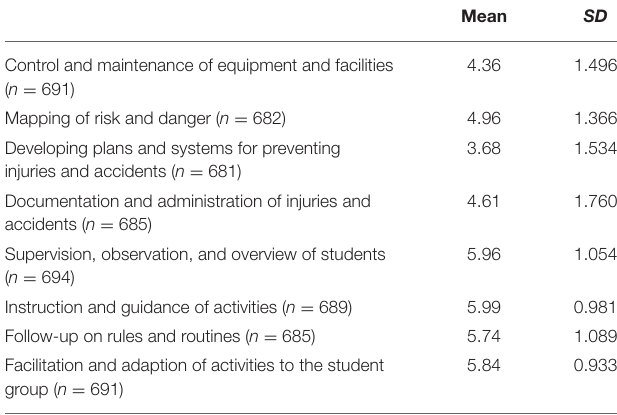
TABLE 5 | To what degree are the following elements part of your risk and safety